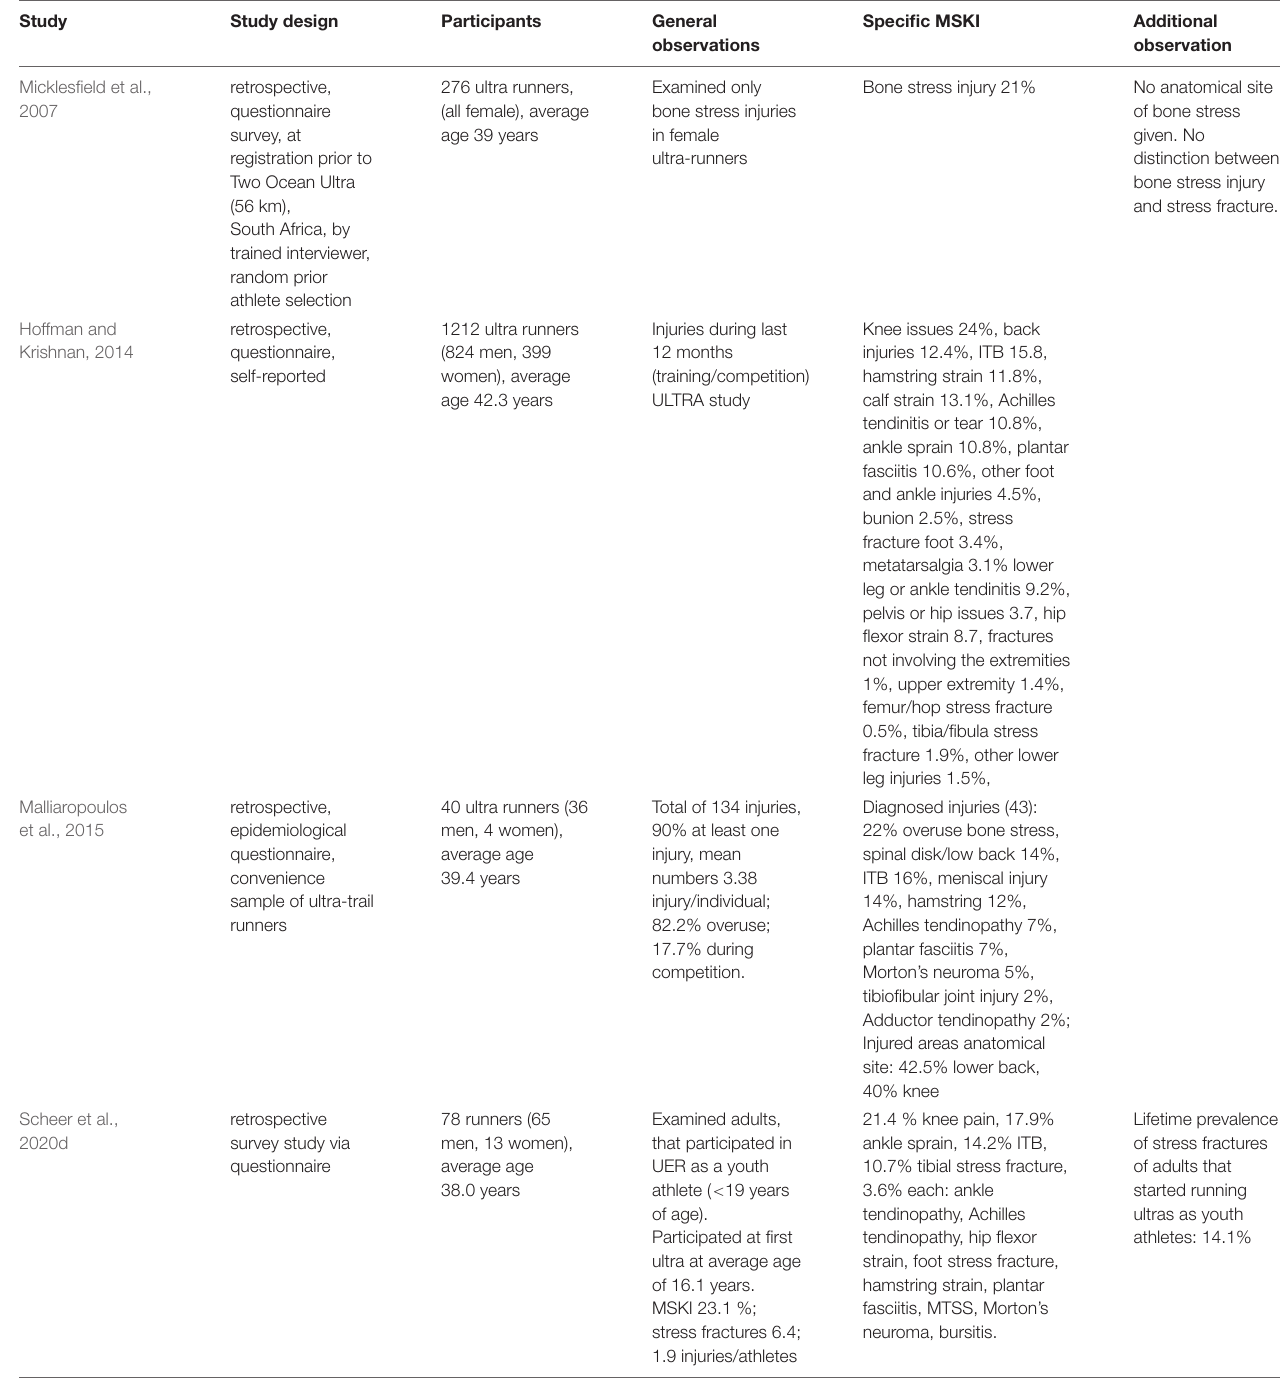
TABLE 2 | Studies investigating musculoskeletal injuries (MSKI) during